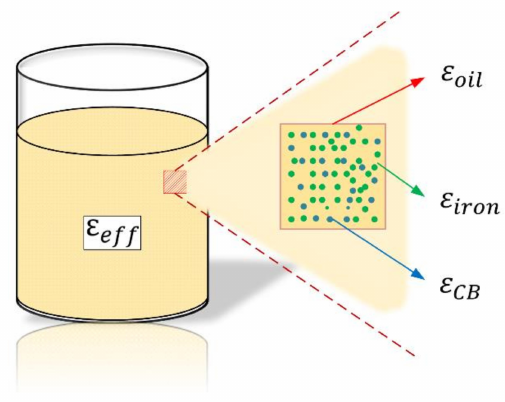
Figure 1. Schematic of randomly dispersed impurities in processing